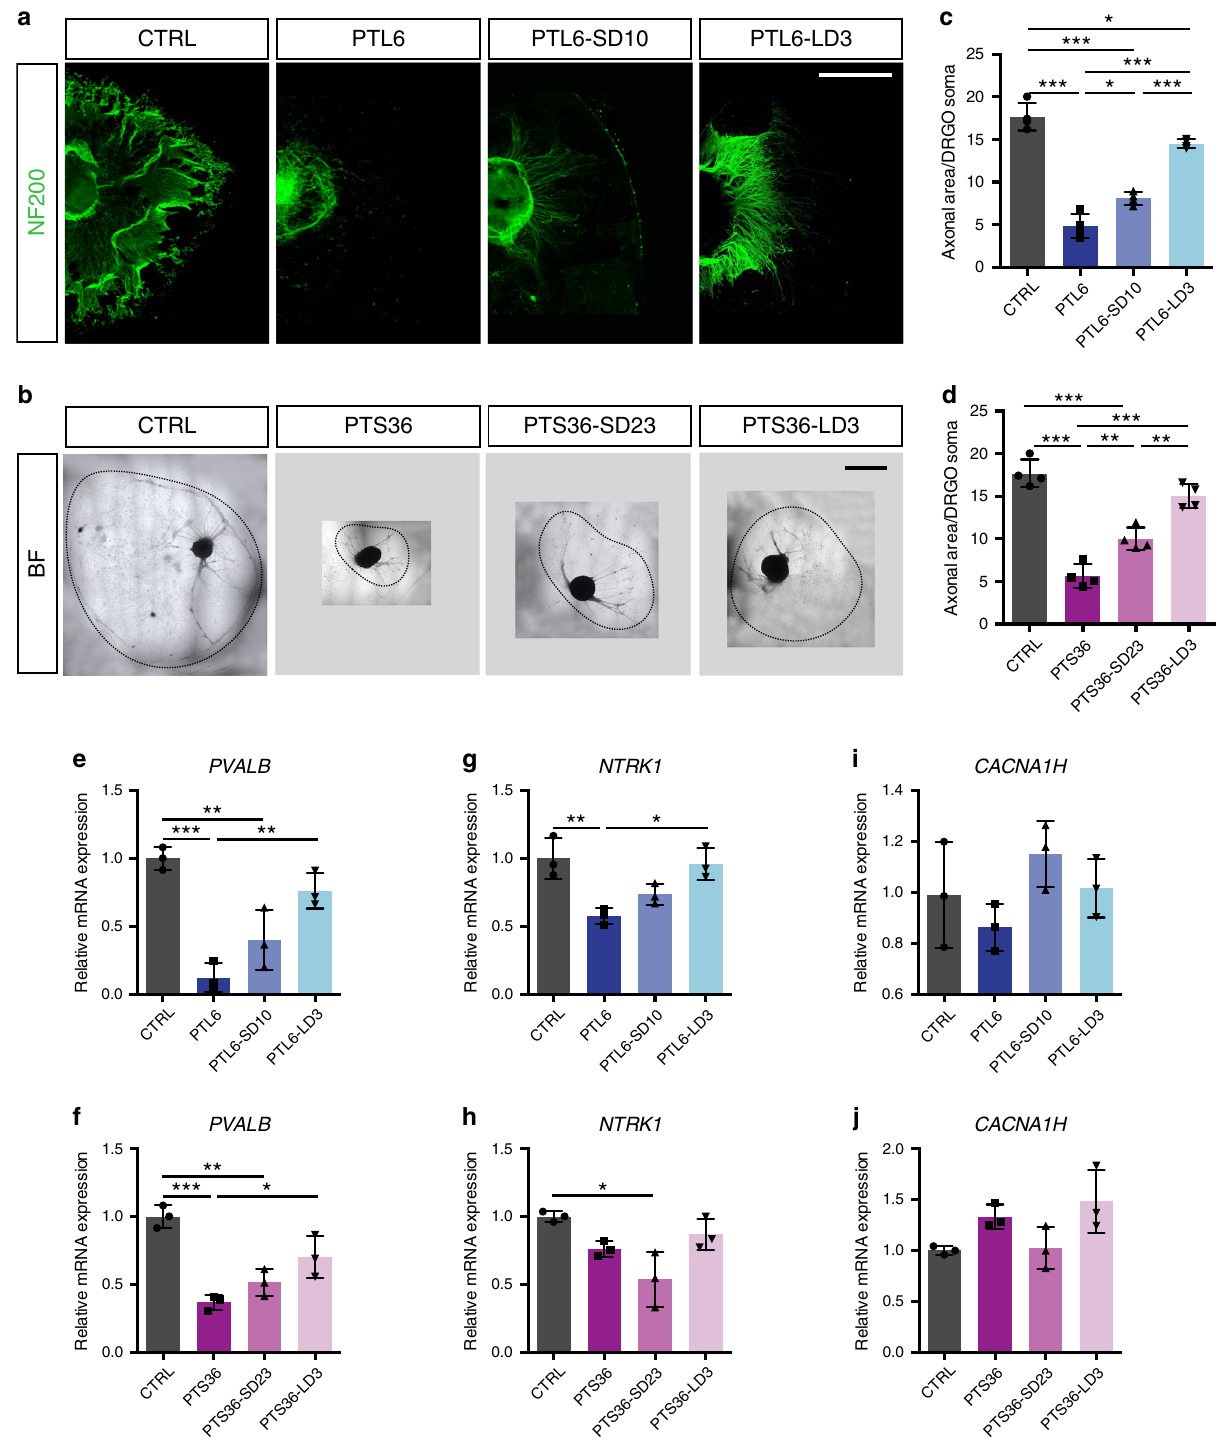
Fig. 6 Disease phenotype amelioration in CRISPR/Cas9 edited FRDA-LD DRGOs. a , d Representative images of FRDA patient line derived DRGOs along with short and long deletion isogenic lines, respectively, as compared with a control (CTRL) healthy donor derived DRGO stained for NF200 ( a ) and in BF ( b ), and neuritis area quanti fi cation for PTL6 and its isogenic lines ( c ) and PTS36 and its isogenic lines ( d ). Mean± s.d., n = 4 independent experiments 3 organoids/line/experiment. * P < 0.05; ** P < 0.01; *** P < 0.001; one-way ANOVA with Bonferroni correction. Scale bar: 500 μ m. e – j Quantitative analysis of transcriptional levels of PVALB (propriorecetors) ( e , f ), NTRK1 (nociceptors) ( g , h ) and CACNA1H (mechanoreceptors) ( i , j ) in control, FRDA patients and their isogenic lines. Expression levels are normalized to actin. Mean ± s.d., n = 3 independent experiments, 8 – 12 organoids/line/experiment. * P < 0.05; ** P < 0.01; *** P < 0.001; one-way ANOVA with Bonferroni